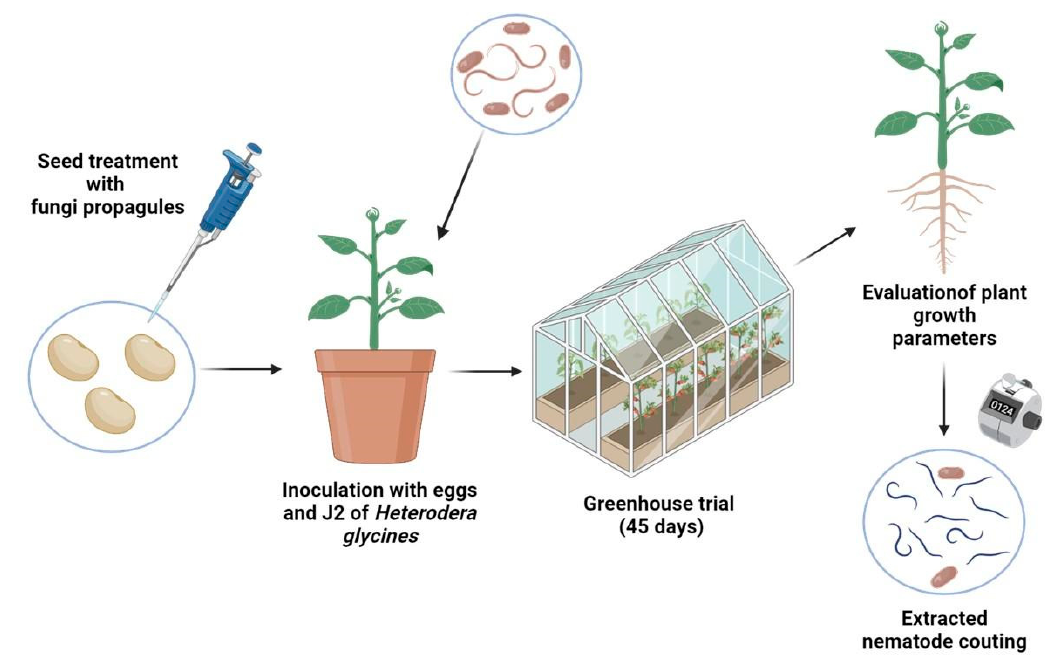
Figure A2. Schematic illustration of the experimental procedure encompassing fungal seed treatment, greenhouse experimental setup, and root extraction for the determination of the final nematode population and nematodes per gram of fresh root mass (Figure created with BioRender.com (Accessed on 8 March 2021).